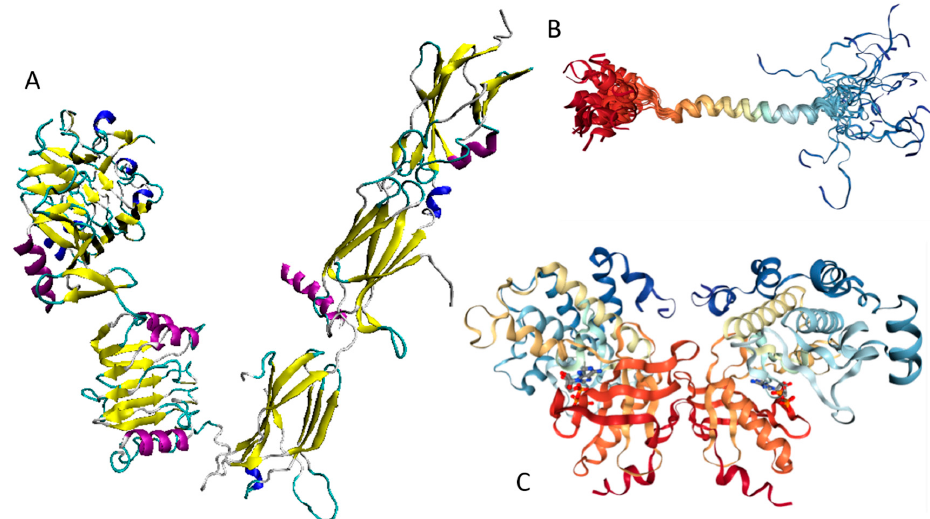
Figure 18. Structural characterization of different functional regions of human insulin receptor (UniProt ID: P06213). ( A ) Crystal structure of the ectodomain (residues 28–955, PDB ID: 4ZXB) [204]. ( B ) Solution NMR structure of the transmembrane domain in detergent micelles (residues 913–961, PDB ID: 2MRF) [220]. ( C ) Crystal structure of the dimeric form of the phosphorylated protein kinase